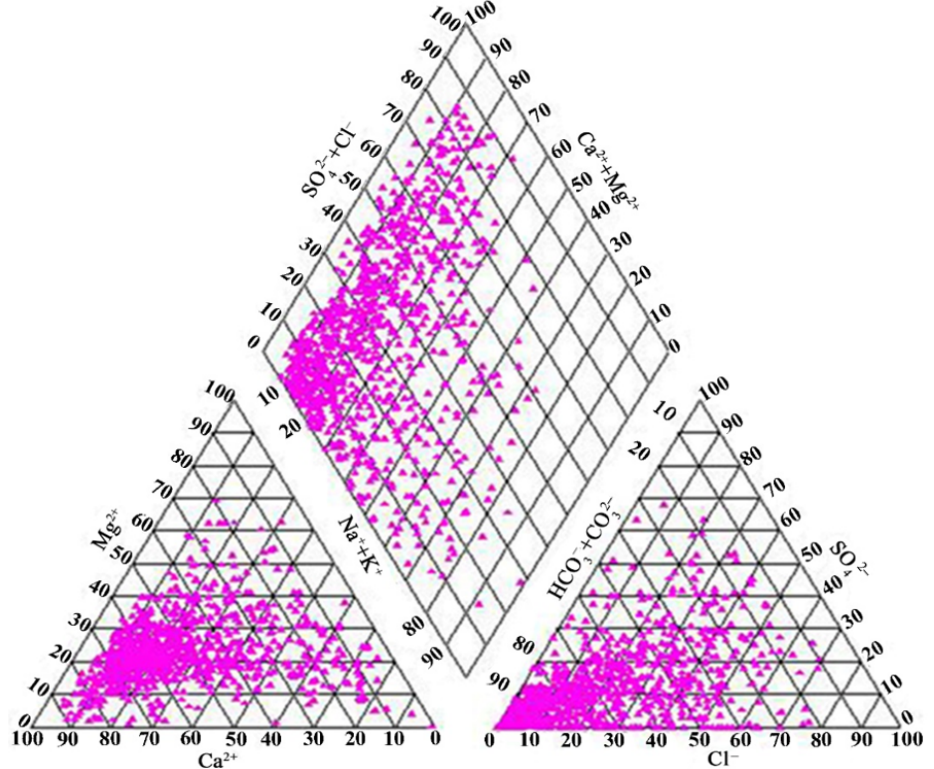
Figure 2. Piper diagram of groundwater samples.